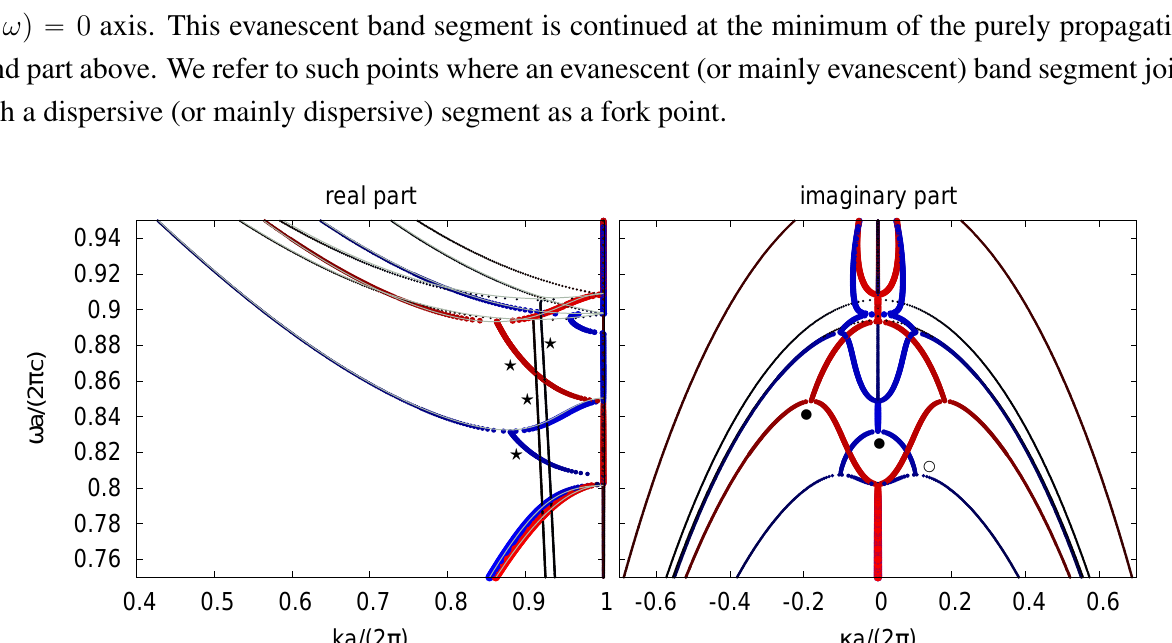
“ 64 3 ą 100 N plane waves MPB